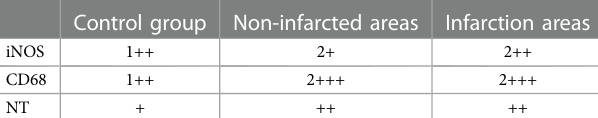
TABLE 3 Mean immunhistological (IHC) staining intensities for iNOS, CD68 and NT in the controls, non-infarcted and infarcted regions. The intensity of immunopositivity was assessed on a scale of 0 – 3 as follows: only perivascular staining (1), perivascular and isolated tissue staining (2) and pronounced perivascular and tissue staining (3). Quantity of staining was indicated by:+(few), normal (++) and strong (+++).